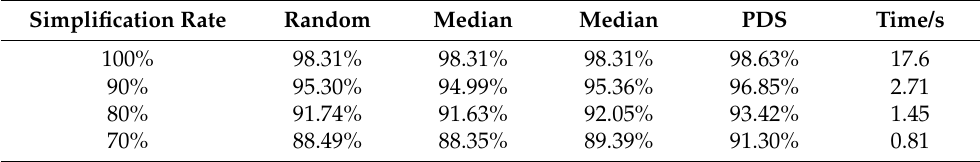
Table 2. Comparison of Volume Accuracy of Different Mesh Simplification Algorithms.